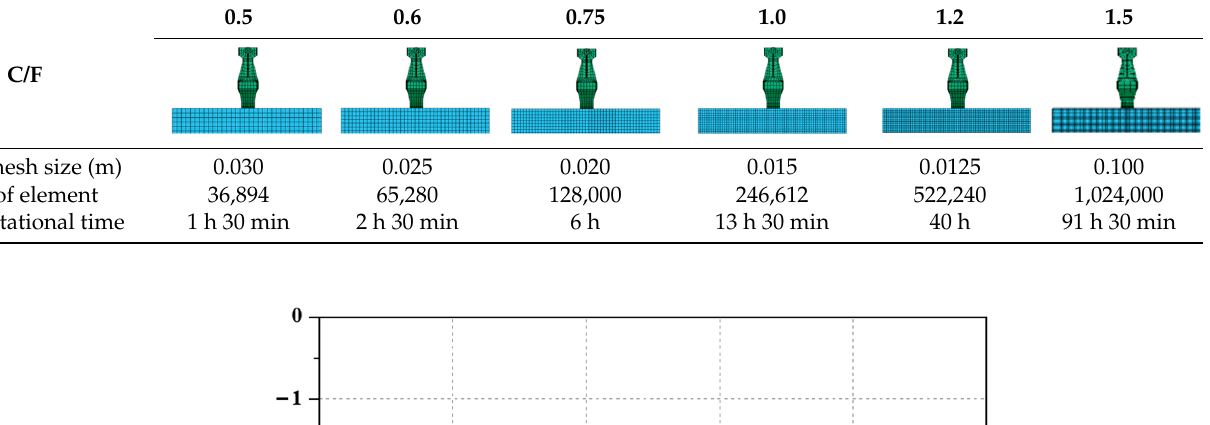
Table 7. The different mesh size in fluid.